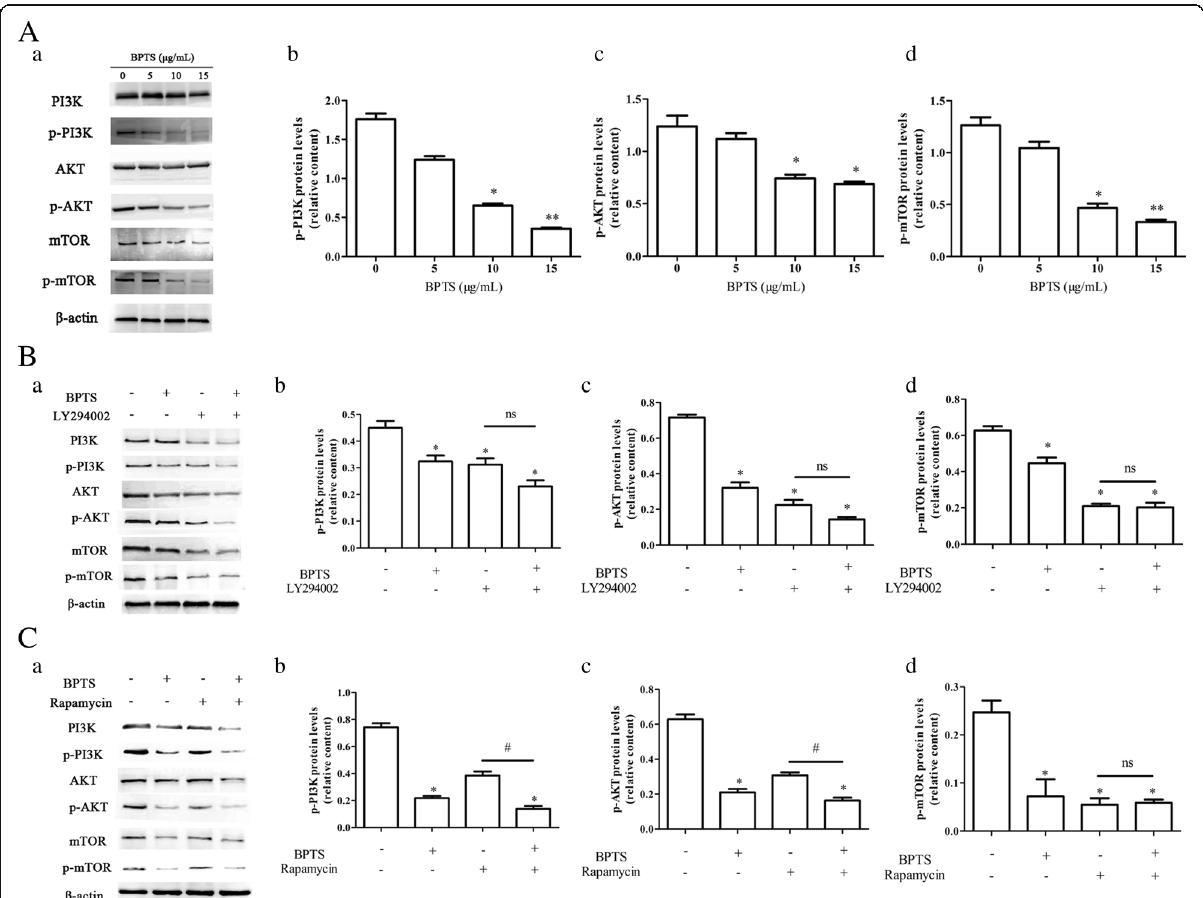
Fig. 3 Protein expression levels of p-PI3K, p-Akt, p-mTOR in MDA-MB-231 cells treated with BPTS. ( A ) Western blot of the proteins in cells treated with BPTS alone, ( B ) BPTS + LY294002 and ( C ) BPTS + rapamycin. ( a ) Representative blot of expression. ( b ), ( c ) and ( d ) Quantification of expression normalized to expression of β -actin. * P <0.05 vs. 0 μ g/mL of BPTS; ns, not